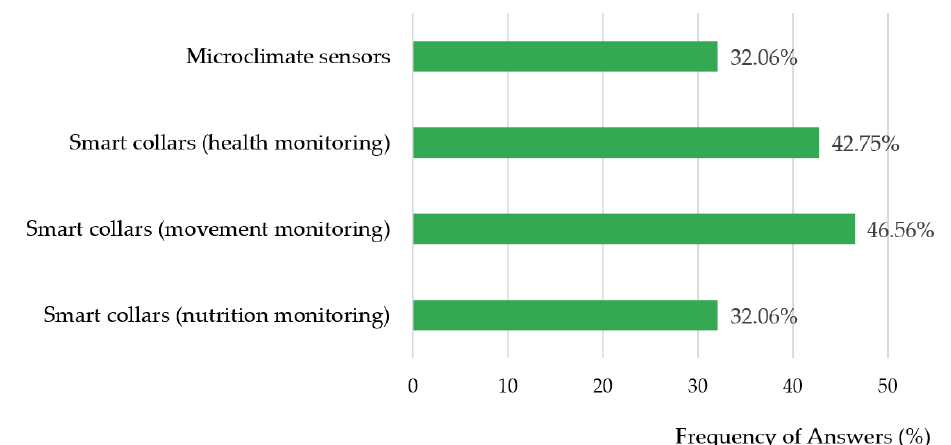
Figure 3. Use of sensors and IoT devices in livestock production. Table 3. The results of statistical evaluation for sensors and IoT in livestock production.